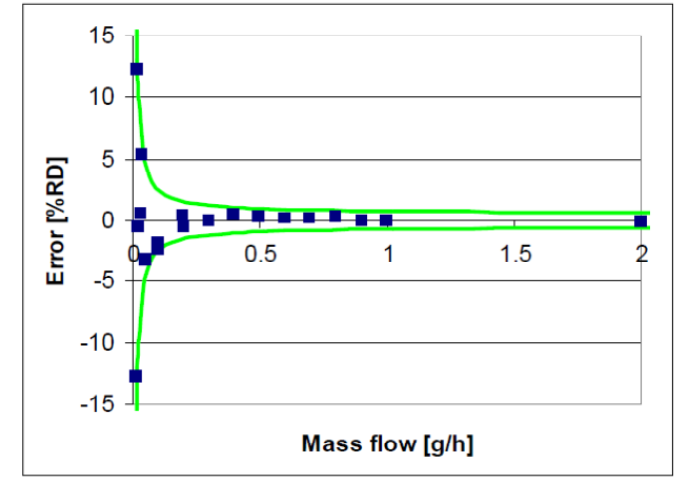
Figure 8. Measured water mass flow vs. Mettler Toledo (AX205 weighing scale). The envelope represents a zero stability of 2 mg/h and an accuracy of 0.5% reading. The pressure drop across the Coriolis mass flow meter was approximately 2 bar.